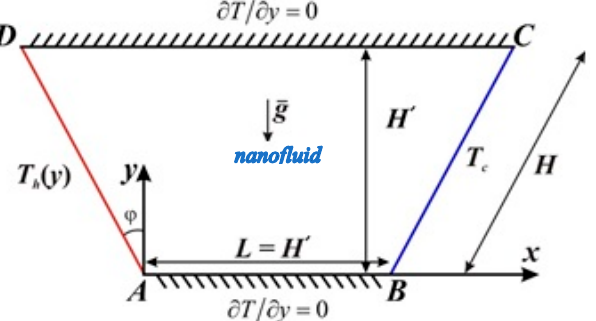
Figure 1. Analyzed sketch and physical model.